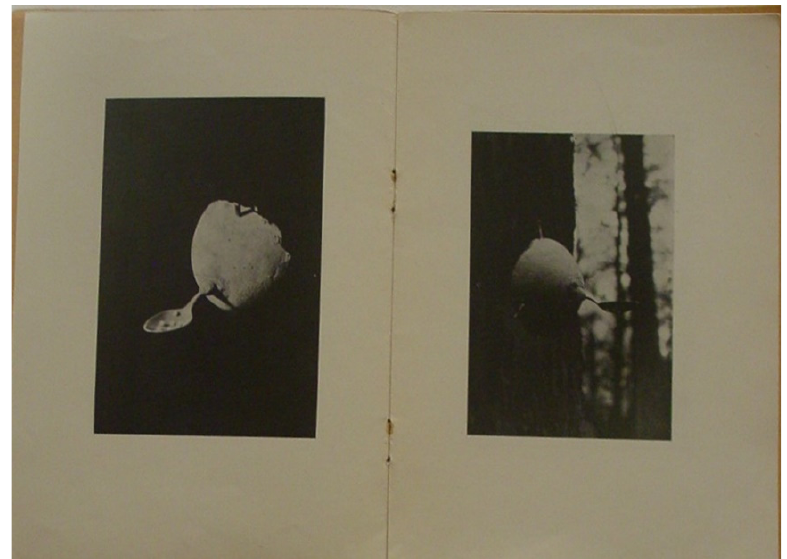
Figure 3. Camille Bryen, Le sein dans la forêt (The Breast in the Forest), 1937. Extract from the book L’Aventure des objets , Paris: José Corti, pp. 8–9. Copyright ADAGP.